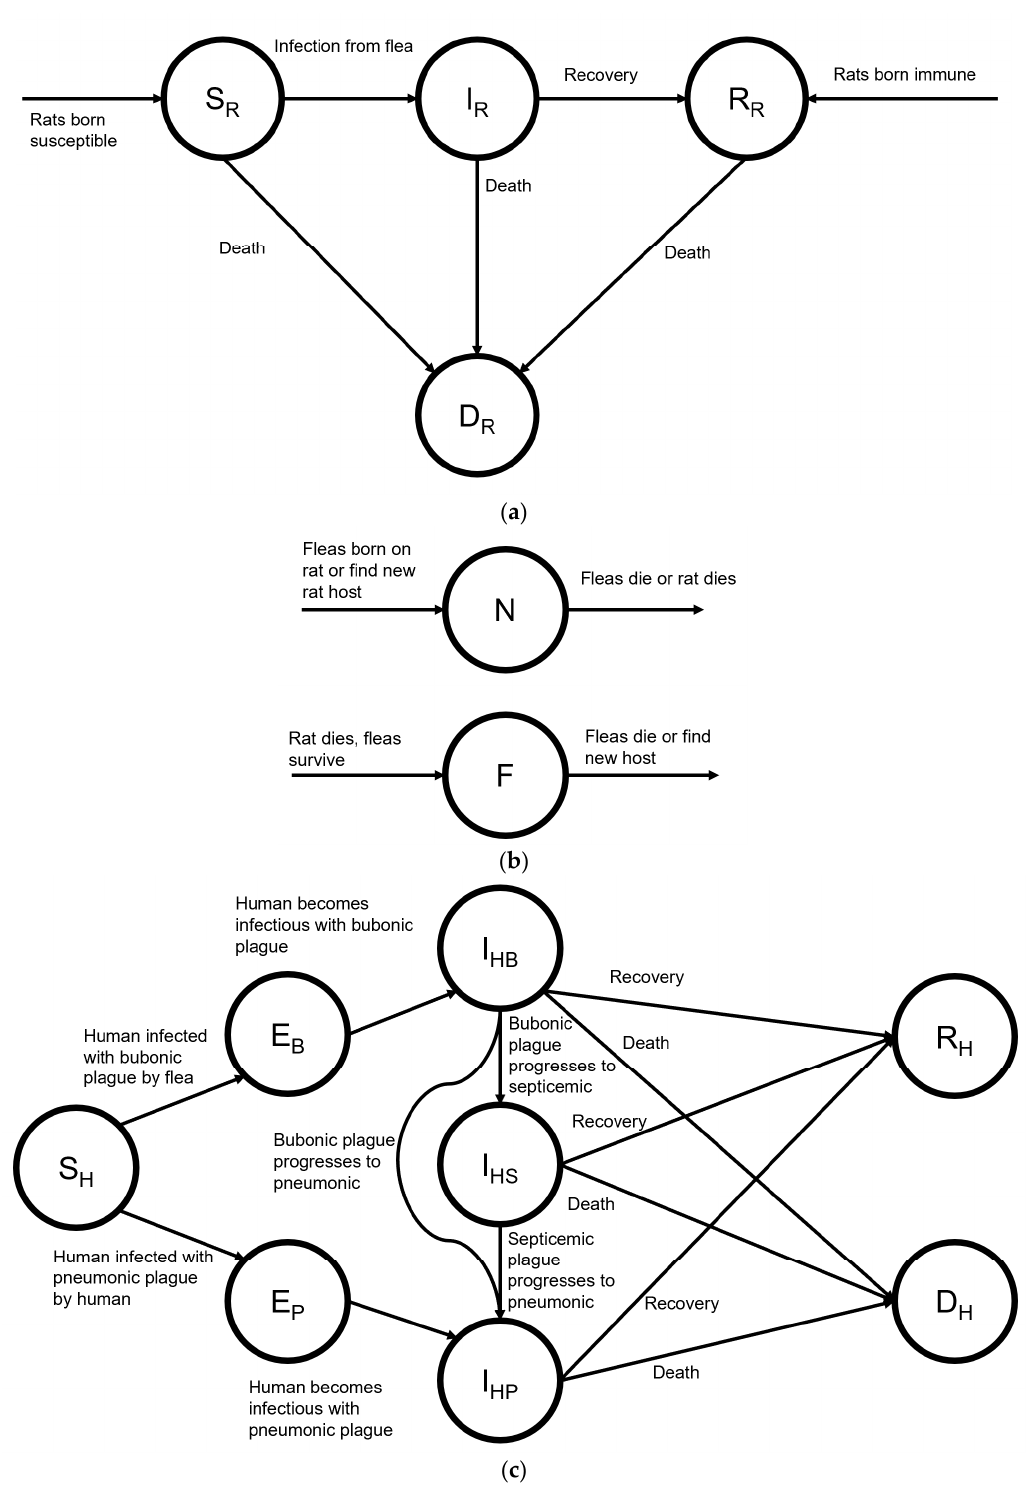
Figure 1. Schematic of a compartmental model of plague transmission among humans, rats, and fleas. The mathematics are described in Equations (S7)–(S15) in the Supplementary Materials. Figure S8 provides the transition rates. ( a ) SIR compartmental model for bubonic plague in rats. ( b ) Compartmental model for fleas carrying bubonic plague. ( c ) SEIR compartmental model for human plague transmission.